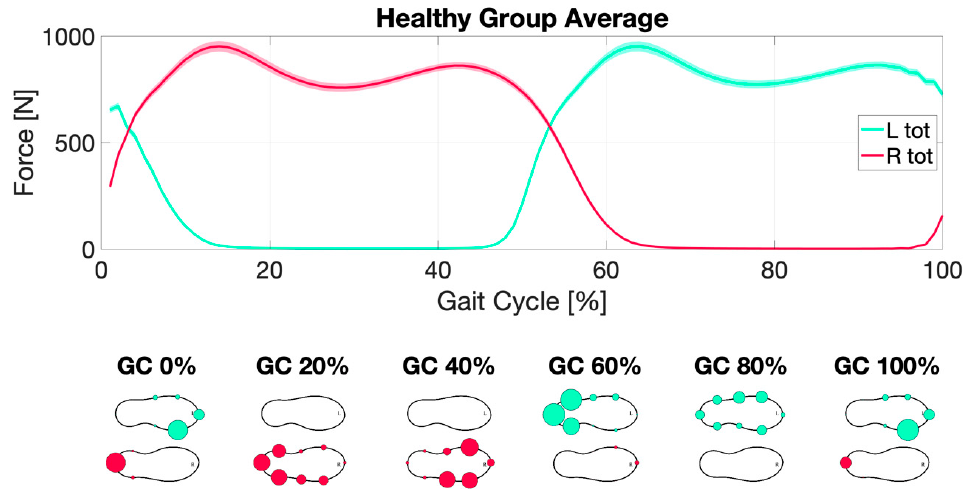
Figure 6. Healthy subjects gait dynamic. Right (R tot) (red line) and Left (L tot) (green line) total force averaged along gait cycles (GC) and subjects over the percentage of completion of the gait cycle (top). The bottom part of the figure represents a graphical visualization of the force measured by the single sensors embedded within the instrumented insole: the larger the circles (right red; left green), the larger the force measured.